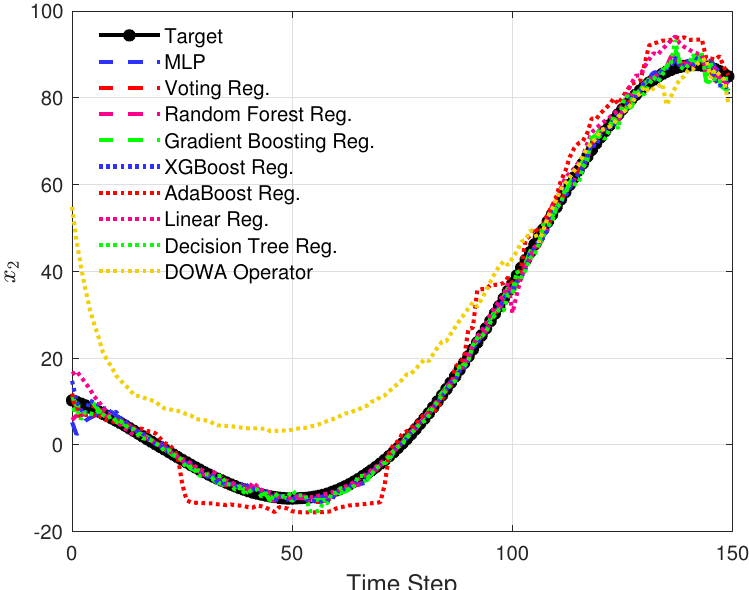
Figure 12. Fusion results for one Monte Carlo simulation for state 2.